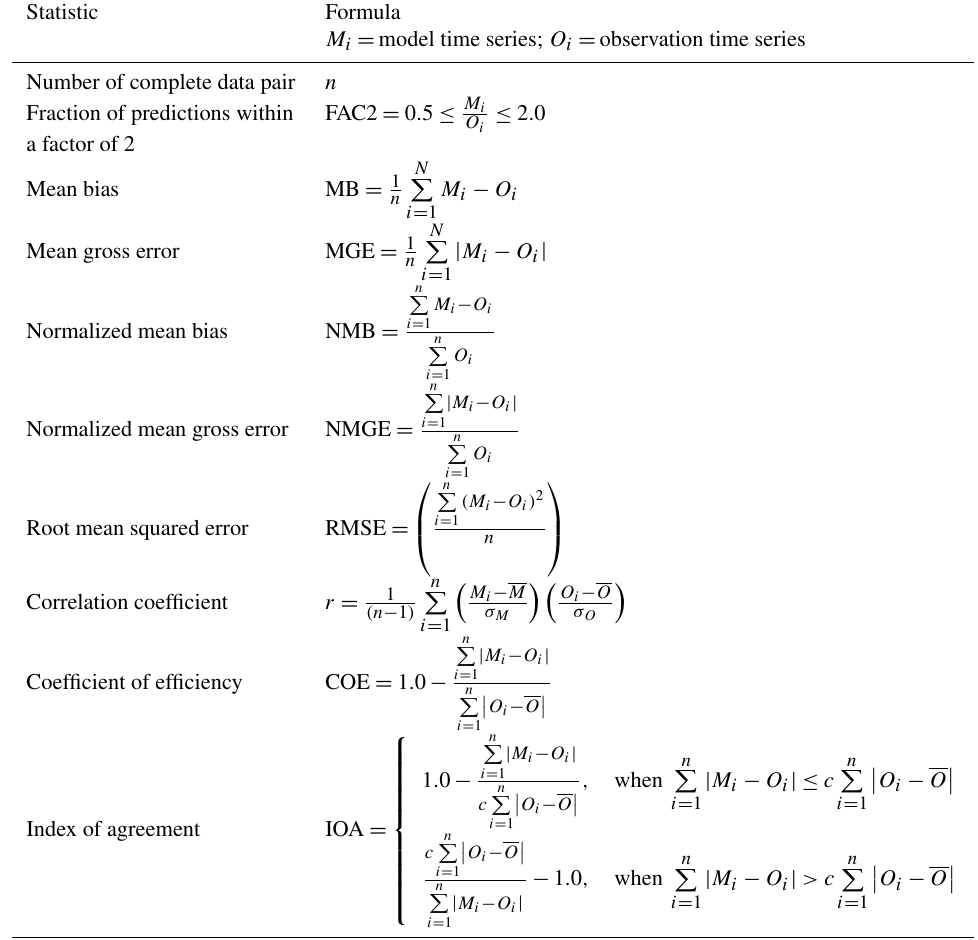
Table 2. Statistical measures used in comparing model results with observations. Statistic Formula M i = model time series; O i = observation time series Number of complete data